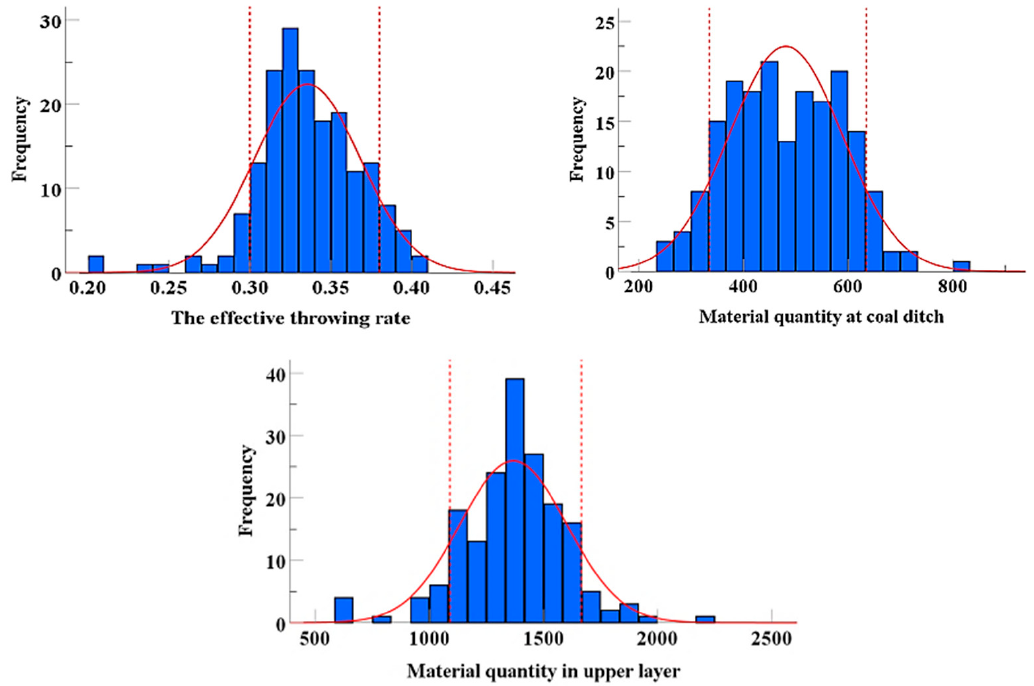
Figure 11. Statistical analysis of a sample set with step height of 40 m.